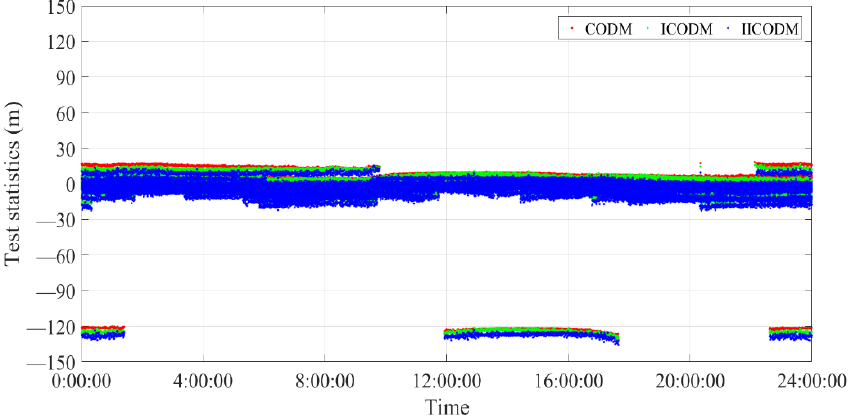
Figure 9. Time series of test statistics of CODM, ICODM and IICODM at BRMG station under case2.